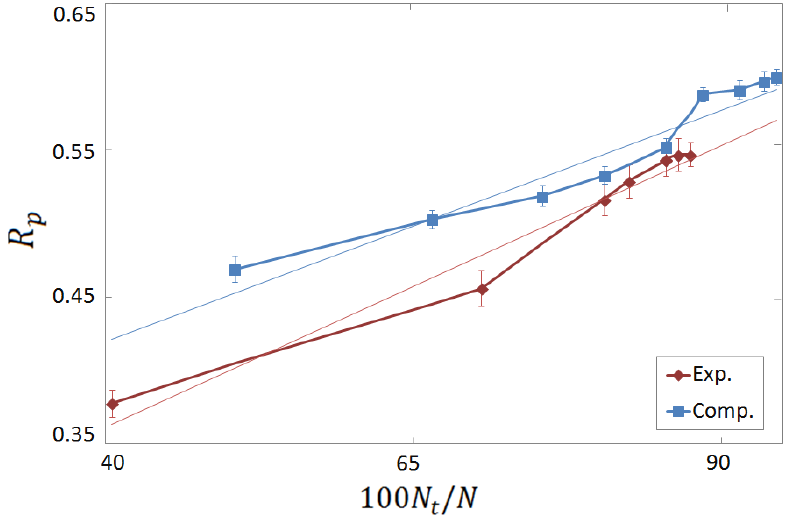
Figure 4. R p prediction–accuracy score as a function of the percentage of the training set size N t compared to the whole database size N , namely, 100 N t / N . The red rhombi and the blue squares correspond to the FCNN SFtrained on the experimental complexes and on the computer-generated complexes,